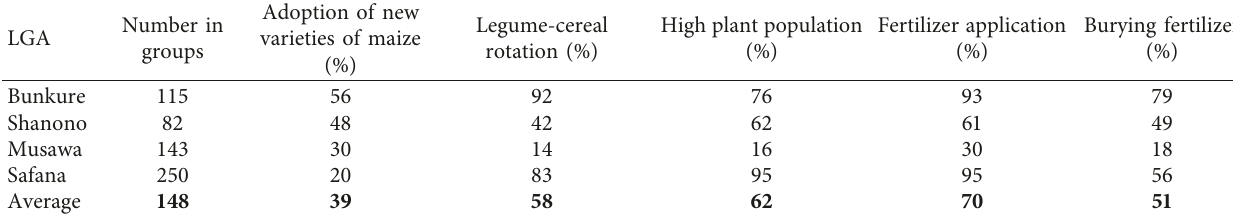
Table 5: Adoption of new maize varieties and management practices reported by farmers.